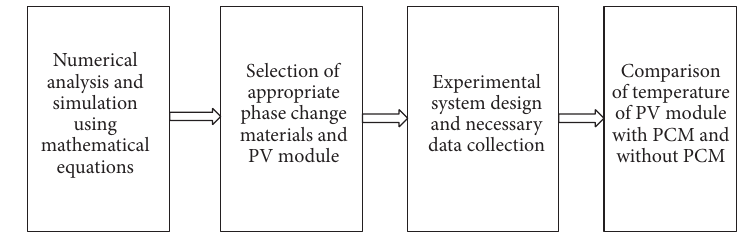
Figure 1: Flow chart of the complete work.